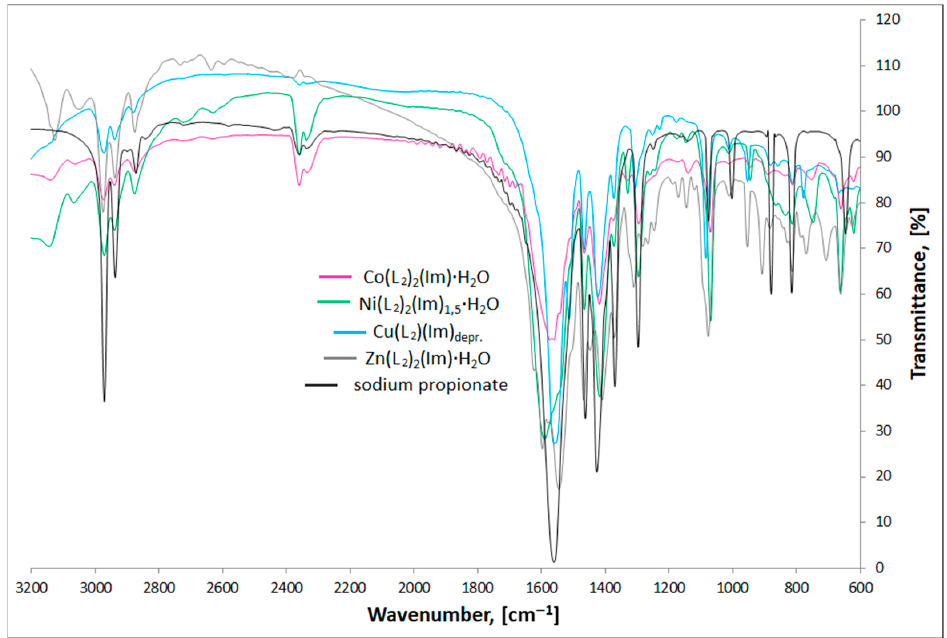
Figure 4. FTIR spectra of studied M(II) propionate-imidazole complexes and sodium propionate. The most important modes observed for studied complexes, sodium formate, and sodium propionate are presented in Table 3.